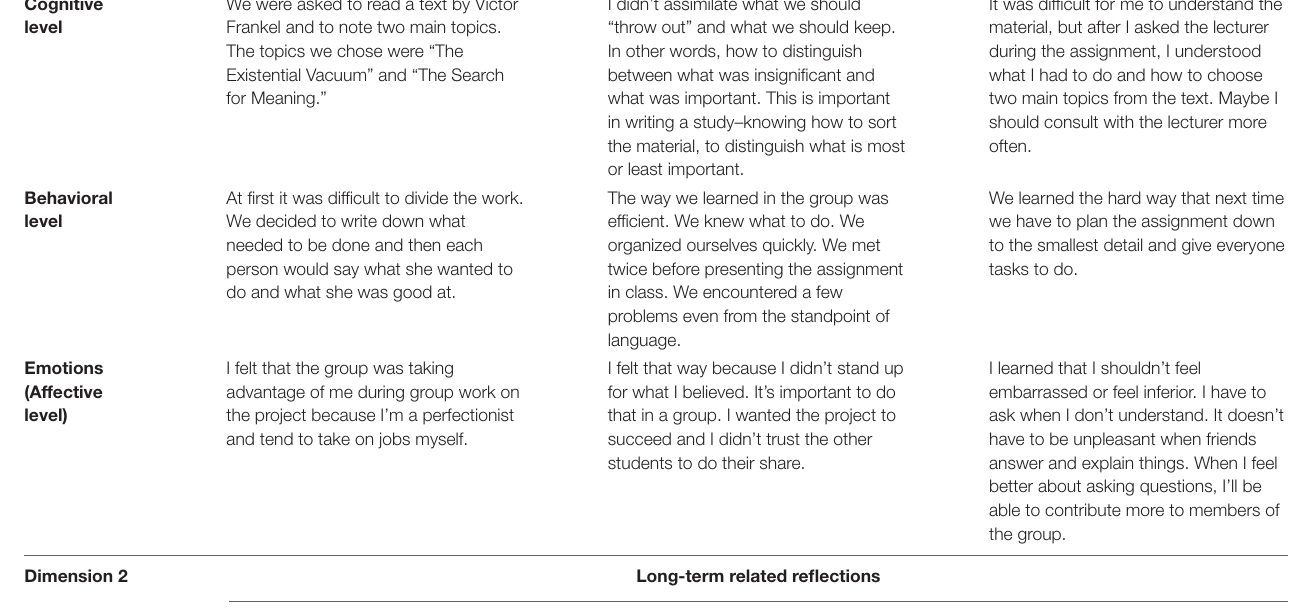
TABLE 1 | Reflective writing scheme and students’ exemplary reflections. Dimension 1 Short-term related reflections Evaluation